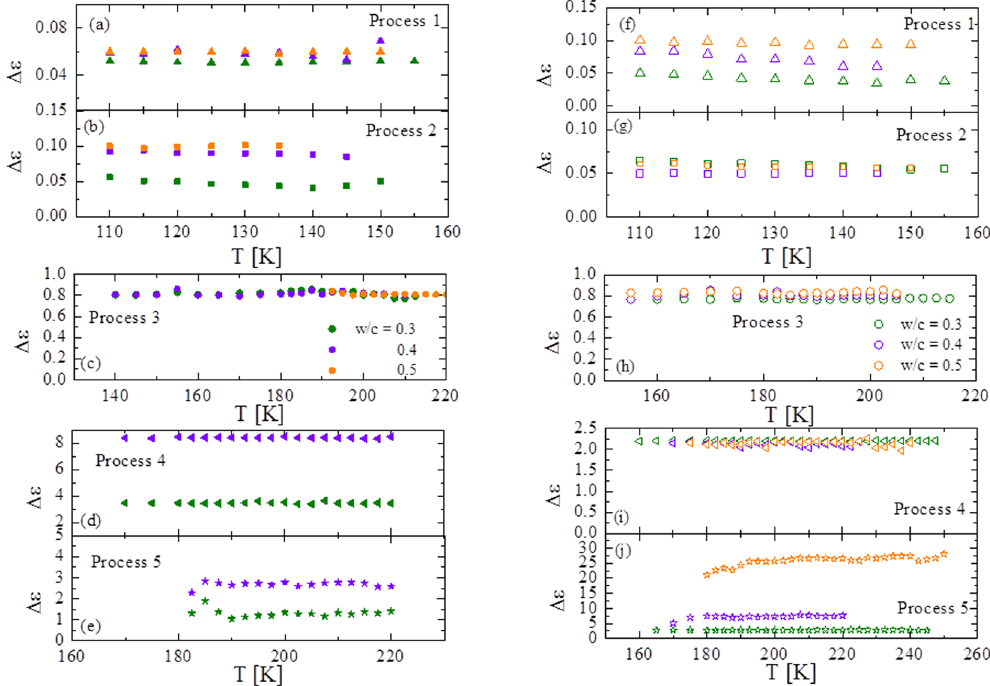
Figure 5. Temperature dependence of relaxation strength ( Δε ) of processes 1 to 5 for samples OPC-3w (left panel) and OPC-4y (right